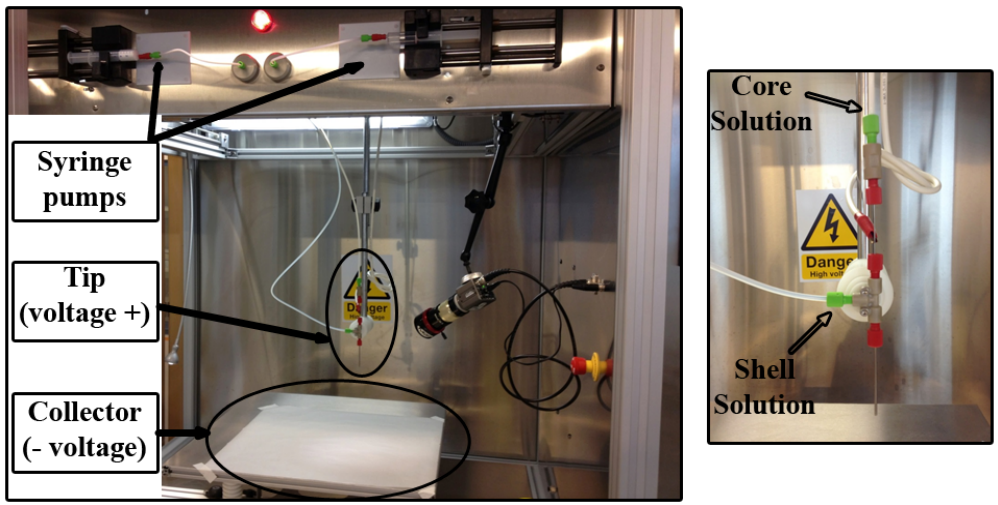
Figure 5. Electrospinning experimental set-up with its main components: syringe pumps, tip and collector. Coaxial injection capillaries can be used (image on the right) to fabricate nanofibrous core-shell